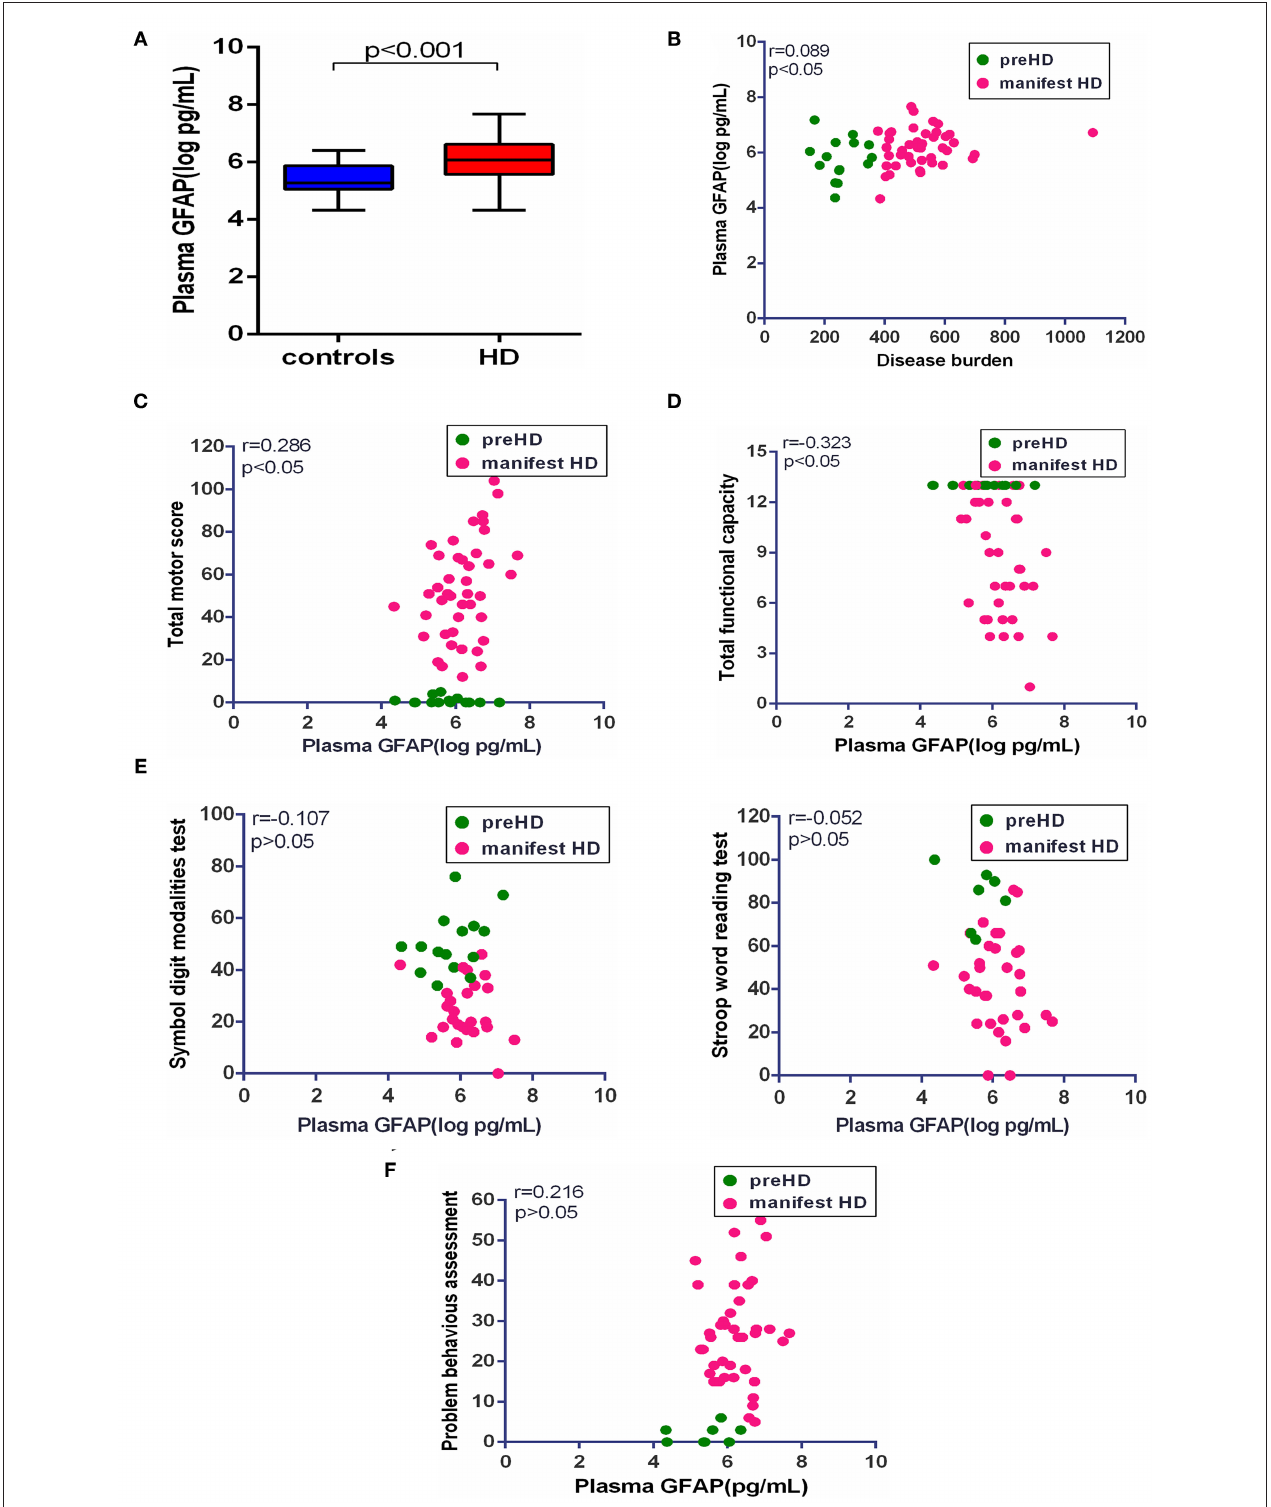
FIGURE 3 | Correlation of plasma GFAP and clinical measures. (A) The concentration of plasma GFAP in healthy controls ( n = 26) and HD mutation carriers ( n = 57). (B) Plasma GFAP was significantly correlated with disease burden in HD mutation carriers. (C) Plasma GFAP was significantly correlated with Total Motor Score in